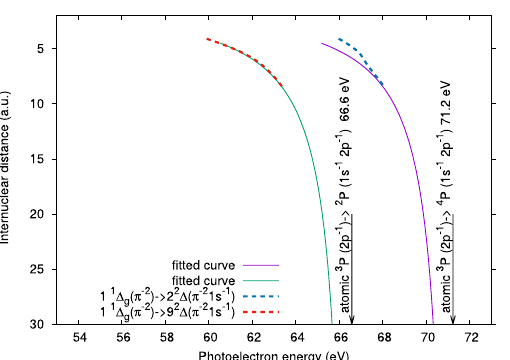
2 1 1 (cid:31) + 2 ( g ) as a function of internuclear distance.